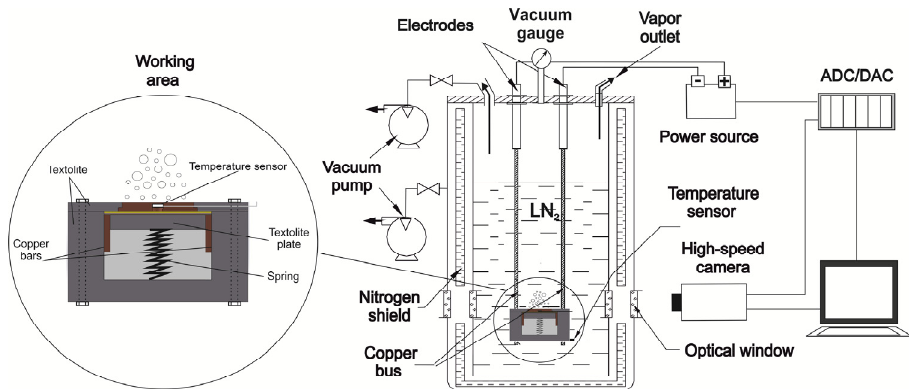
Figure 1. Scheme of the experimental setup and test section. The plates made of duralumin D16T with roughness R a = 1 µm (average roughness), R z = 7.1 µm (maximum height to minimum depth), dimensions of 22 × 22 mm, and a thickness of 3 mm were used as the working samples. It should be noted that the samples were made on a milling machine and were not subjected to further processing (grinding, polishing); therefore, the heat transfer surface had a specific microstructure characteristic of technical surfaces. A groove was made along the perimeter of each working sample to connect the section with the textolite body (see the test section scheme, Figure 1). The textolite body, consisting of two halves, was connected with four bolts. To exclude liquid inflows in the test section, all component parts of it were sealed with epoxy glue. The Hel-700 series pre-calibrated platinum resistance temperature detector (RTD) was in- stalled in the center of each sample at a distance of 0.5 mm from the heat releasing surface, which allowed surface temperature measurements with an absolute error not exceeding 0.2 K. A thin layer of highly heat conductive thermal paste (11 W/mK) was ap- plied between the sensor body and the test sample to ensure good thermal contact, and epoxy adhesive was used to fix the sensor securely. The RTD was connected in a